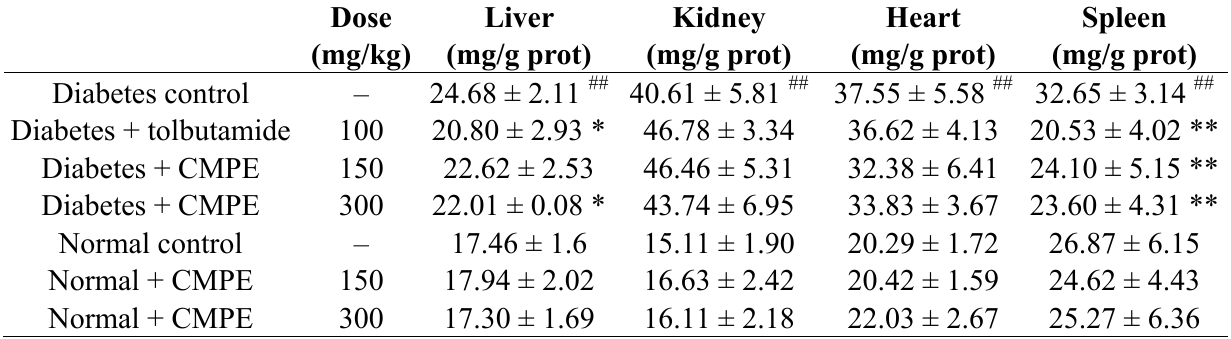
Table 3. Effects of CMPE on MDA levels in tissues of normal and STZ induced diabetic